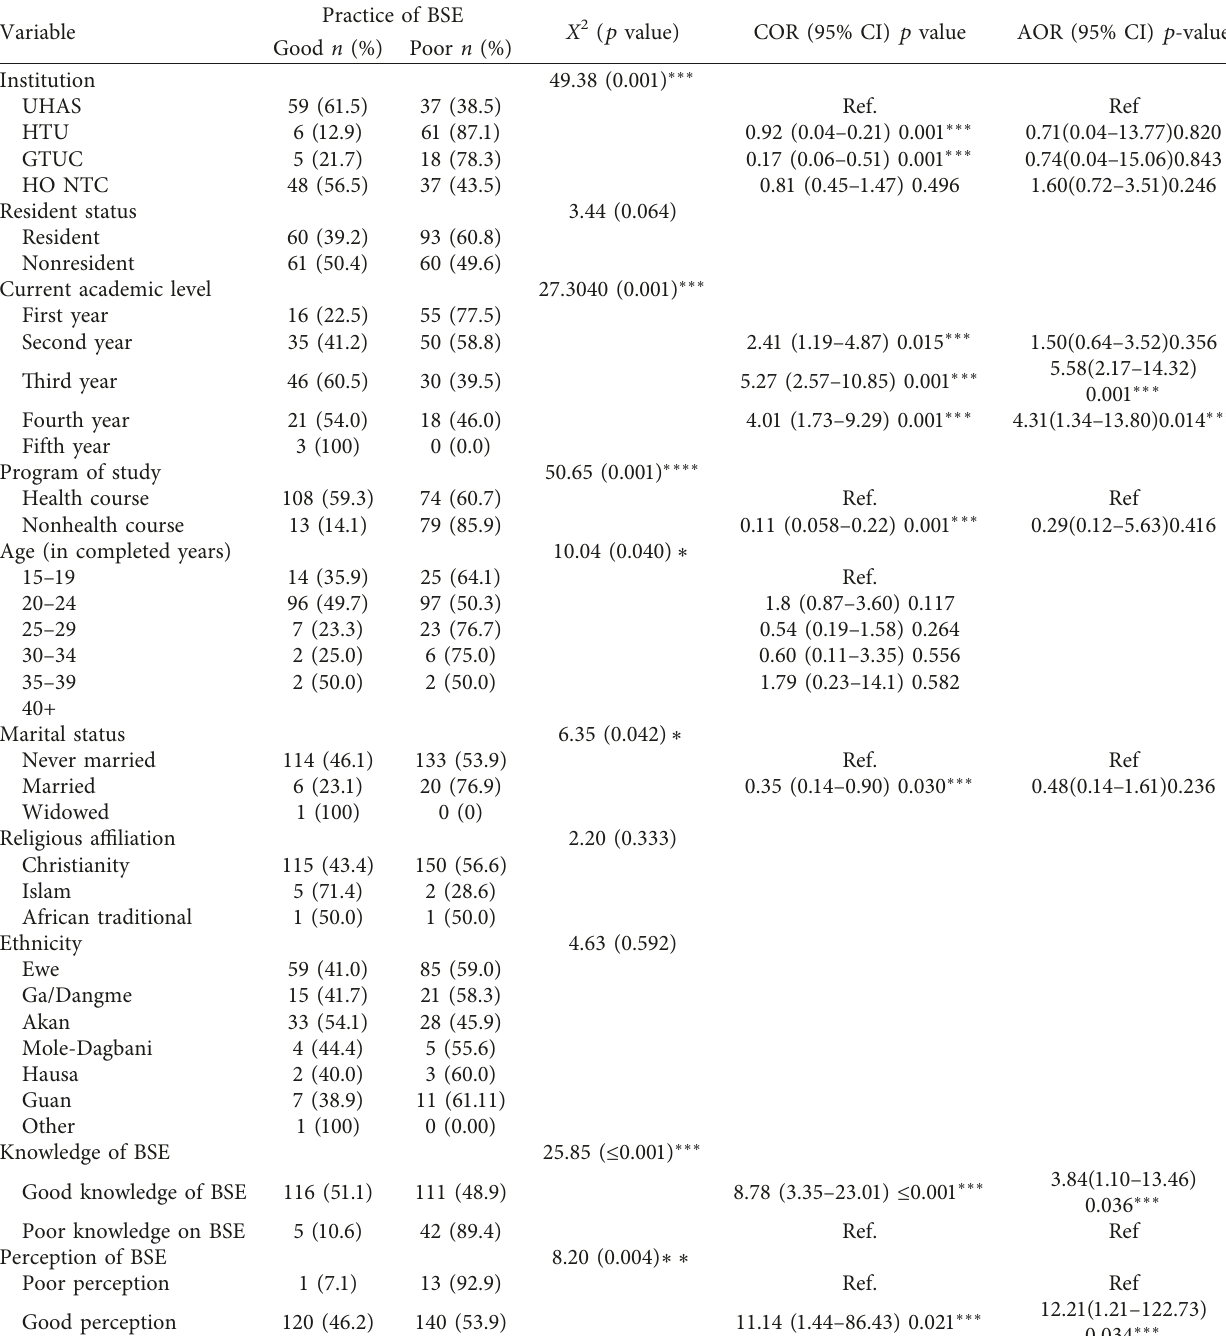
Table 3: Bivariable and multivariable analyses on the factors influencing BSE